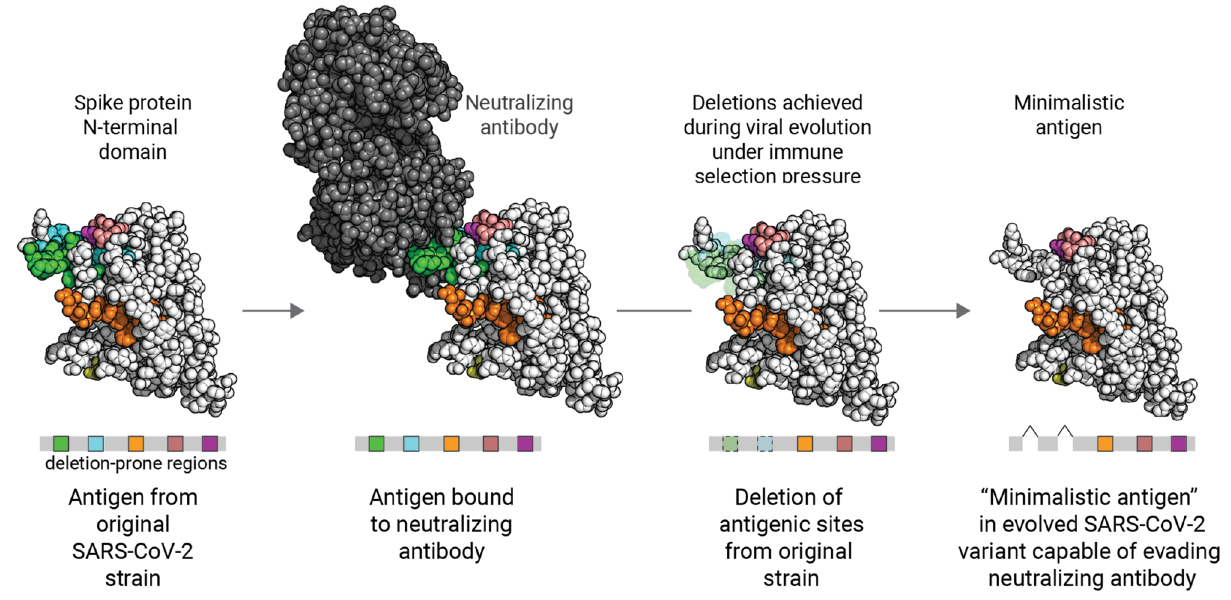
Figure 4. Schematic overview of the Spike protein N-terminal domain acquiring deletion mutations during evolution to evade immune responses. The deletion mutations occur concurrently with other substitution mutations (not highlighted) in the background. The schematic was made using a three-dimensional structure obtained from the Protein Data Bank (PDB identifier: 7C2L described by Chi et al.). 18